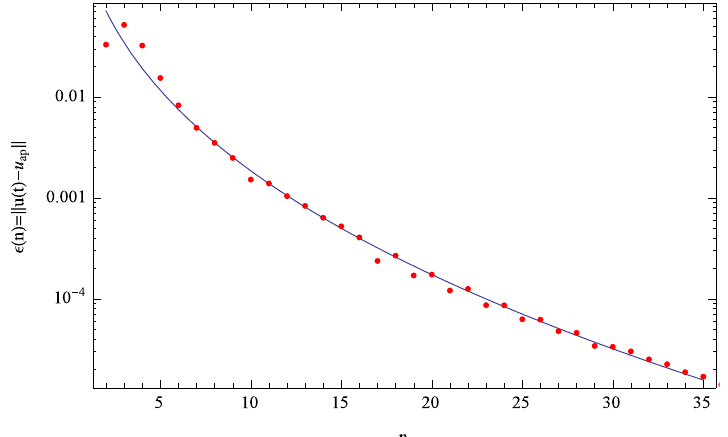
j of the solution on the interval t 2 [0 ; 10] . ap